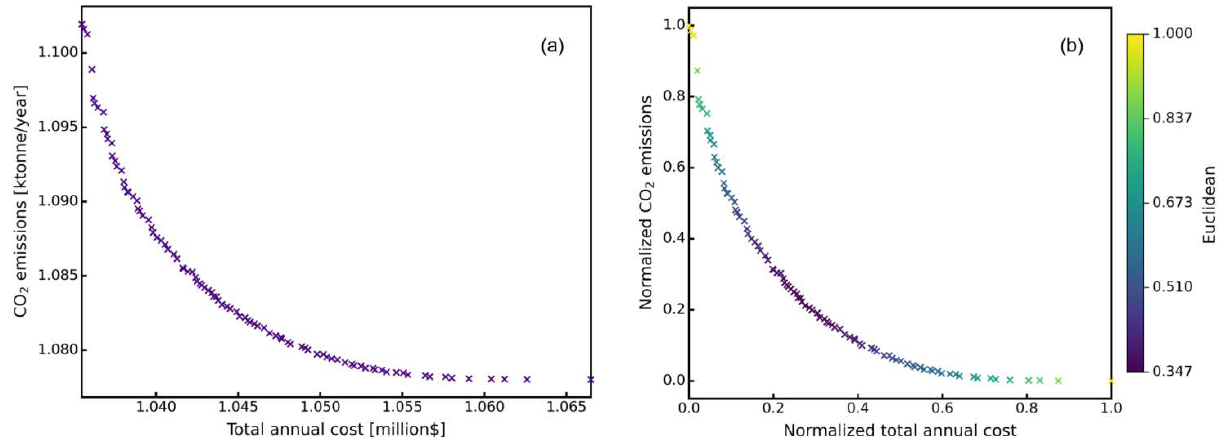
Figure 12. Pareto sets of TAC and CO 2 emissions: ( a ) raw result and ( b ) normalized result.